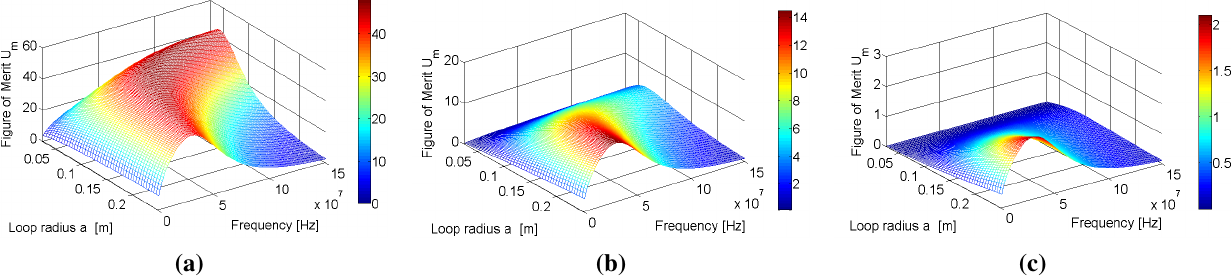
Figure 5. Variation of the figure of merit U frequency f and loop radius a for (a) d = 0 . 01 m, (b) d = 0 . 1 m and (c) d = 0 . 5 m for the 0 parallel